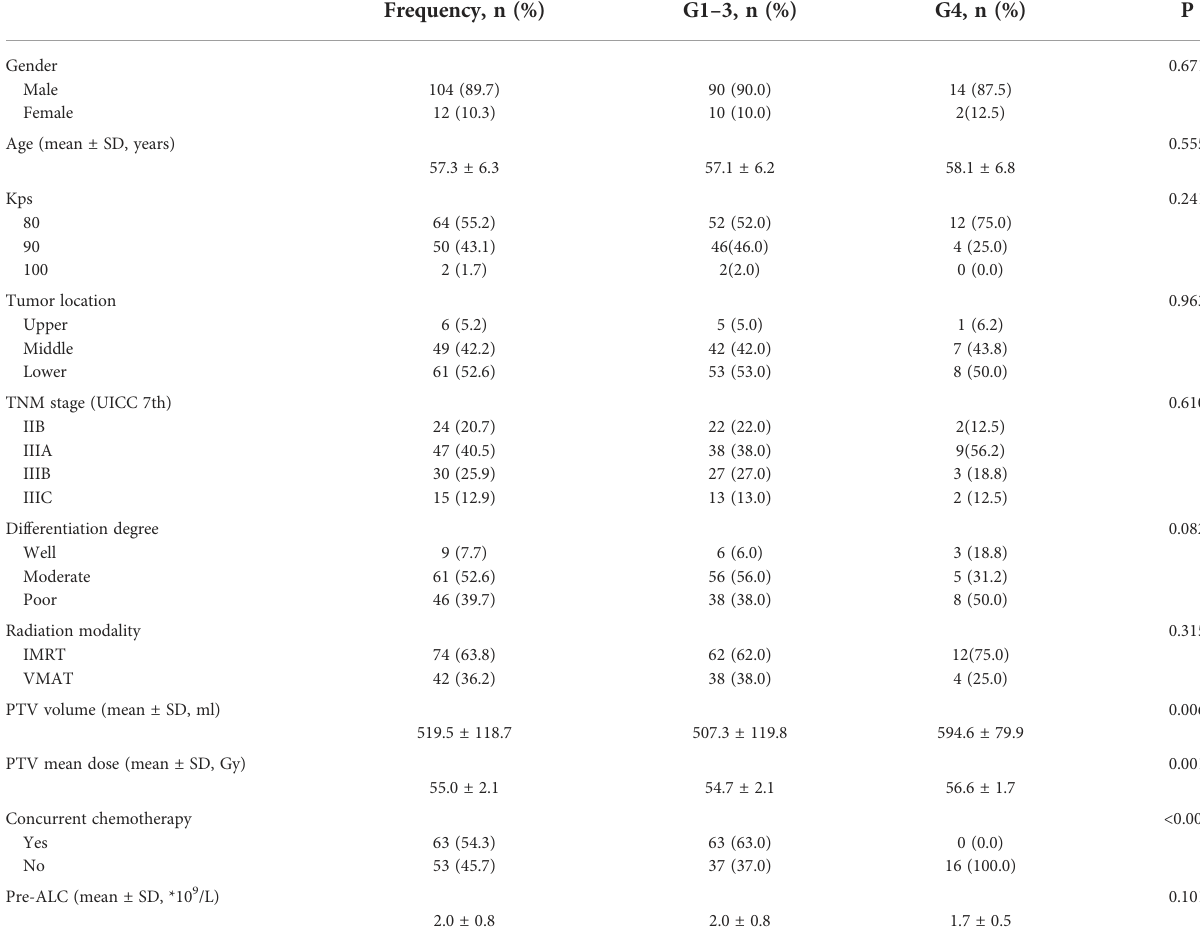
TABLE 2 Comparison of patient characteristics between lymphopenic